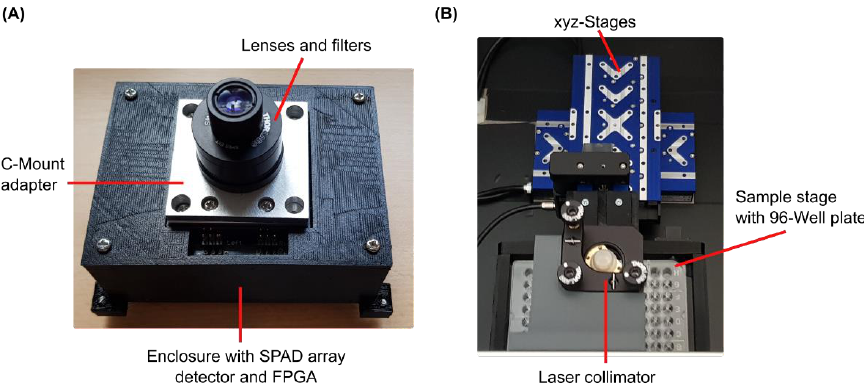
Figure 3. Images of the experimental FL setup: ( A ) SPAD array detector with the lenses and filters attached in a tube housing mounted via a C-mount adapter. ( B ) Top view of the measurement setup with the laser and collimator mounted on top, the optical path of which is directed to a well in the underlying 96-well plate, adjustable in three axes by three stages. The SPAD array detector from ( A ) is located below the illuminated well.